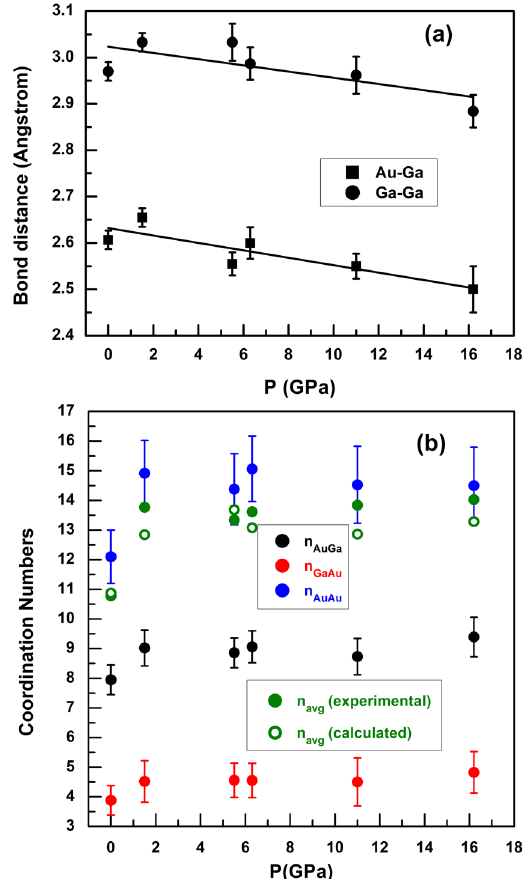
Figure 6. ( a ) Pressure dependence of Au-Ga (nearest-neighbor) and Ga-Ga bond distances determined from partial pair distribution functions (Fig. 5). ( b ) Coordination numbers around Au- and Ga-atoms, n AuGa , n GaAu and n AuAu , and experimental and calculated average coordination numbers.